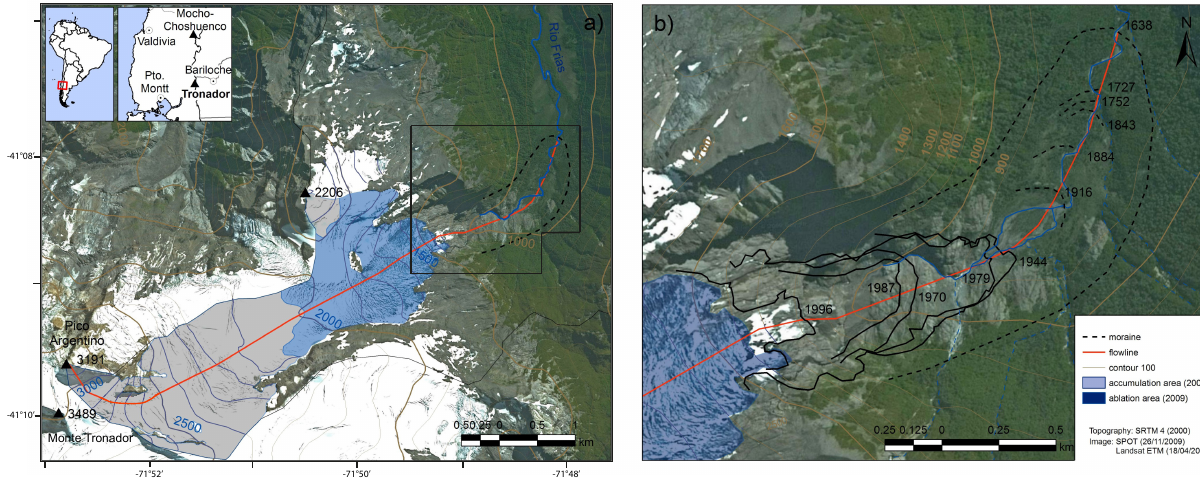
Fig. 1. (a) Topography of Glaciar Fr´ıas, flowing from the Argentinean summit on the northern slopes of Monte Tronador. The accumulation and ablation area of Glaciar Fr´ıas (2009) are indicated with grey and blue shading, respectively. The central flowline is given in red, and altitude in 100m contour lines. The location of Monte Tronador is shown in the insets. (b) Close-up of the glacier forefield with the observed and reconstructed glacier terminus positions. For clarity, not all observations are included; see Table 1 for the complete length